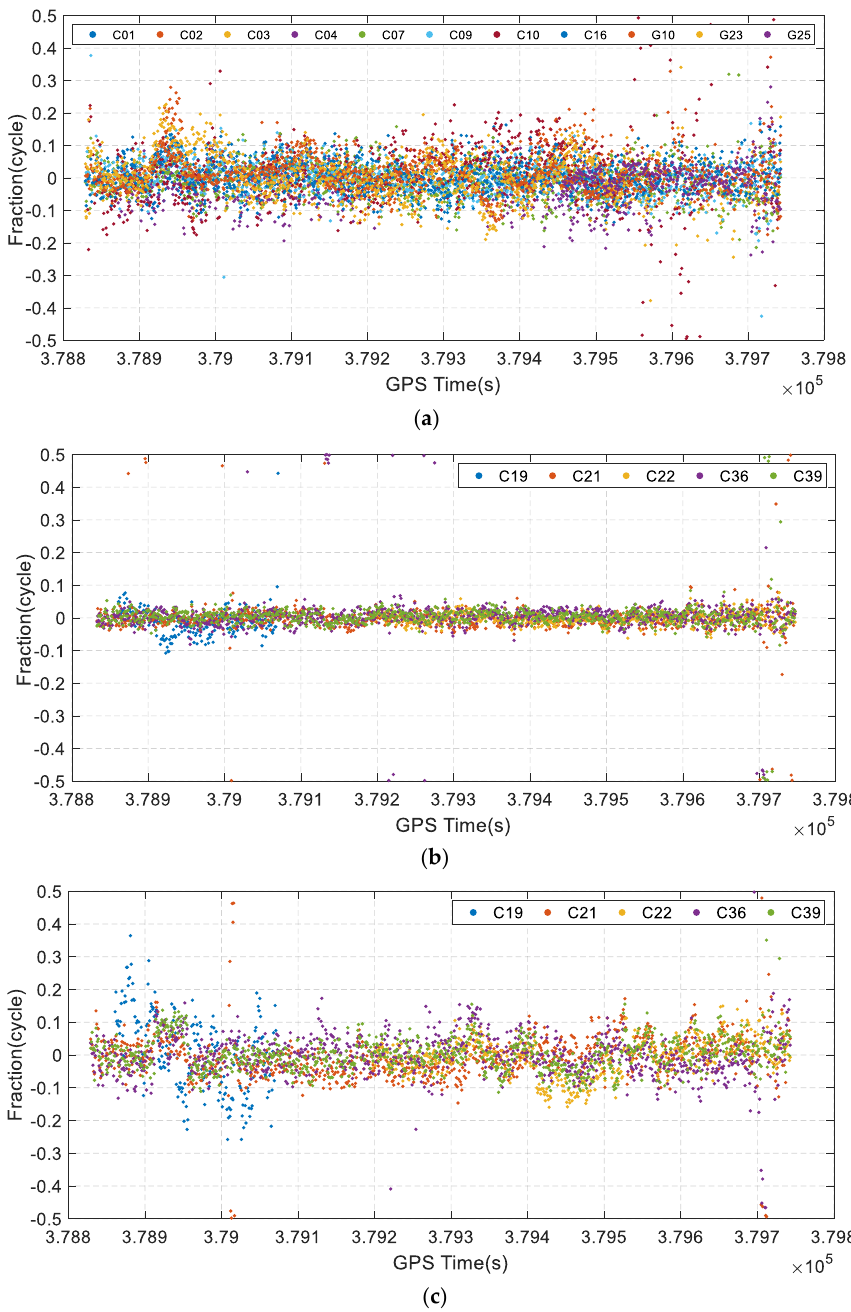
Figure 7. The EWL ambiguity fractions of the GPS/BDS-2 and BDS-3: ( a ) GPS/BDS-2; ( b ) BDS-3 EWL1; ( c ) BDS-3 EWL2.